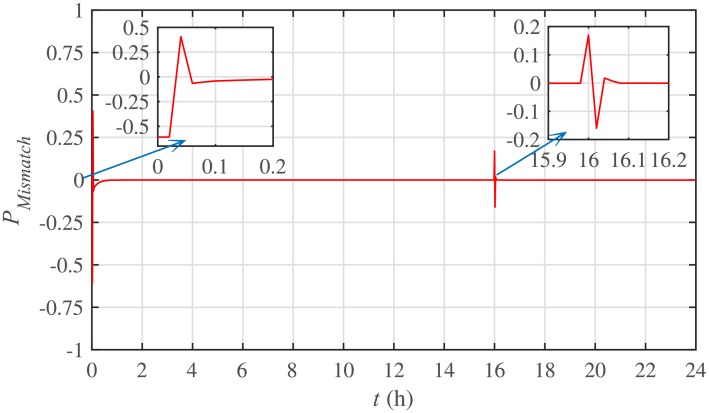
Power mismatch under case 1.